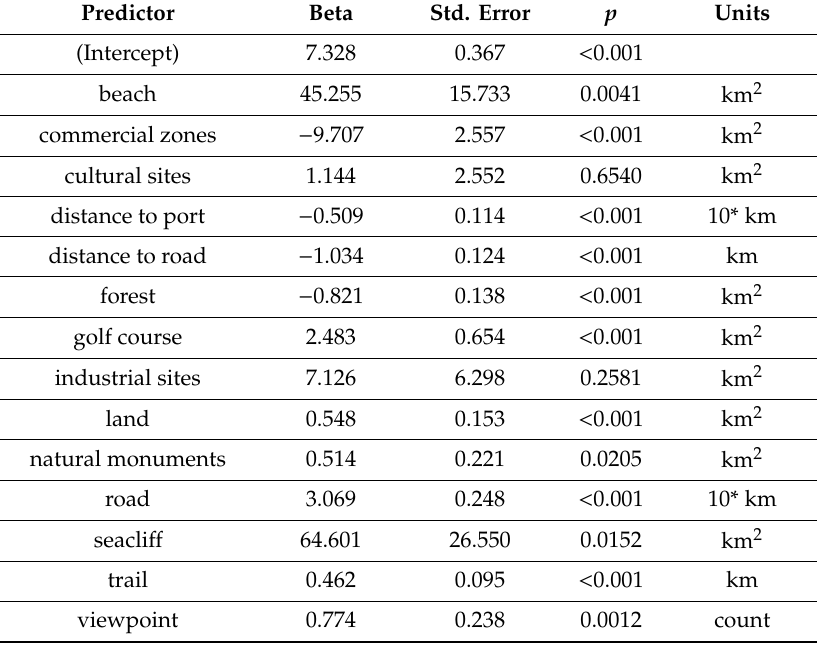
Table 2. Coe ffi cients, standard errors of the estimates, p-values, and the scale analyzed for the 14 predictor variables included in a multivariate regression analysis with the response variable as the linear combination of PUD, TUD, and